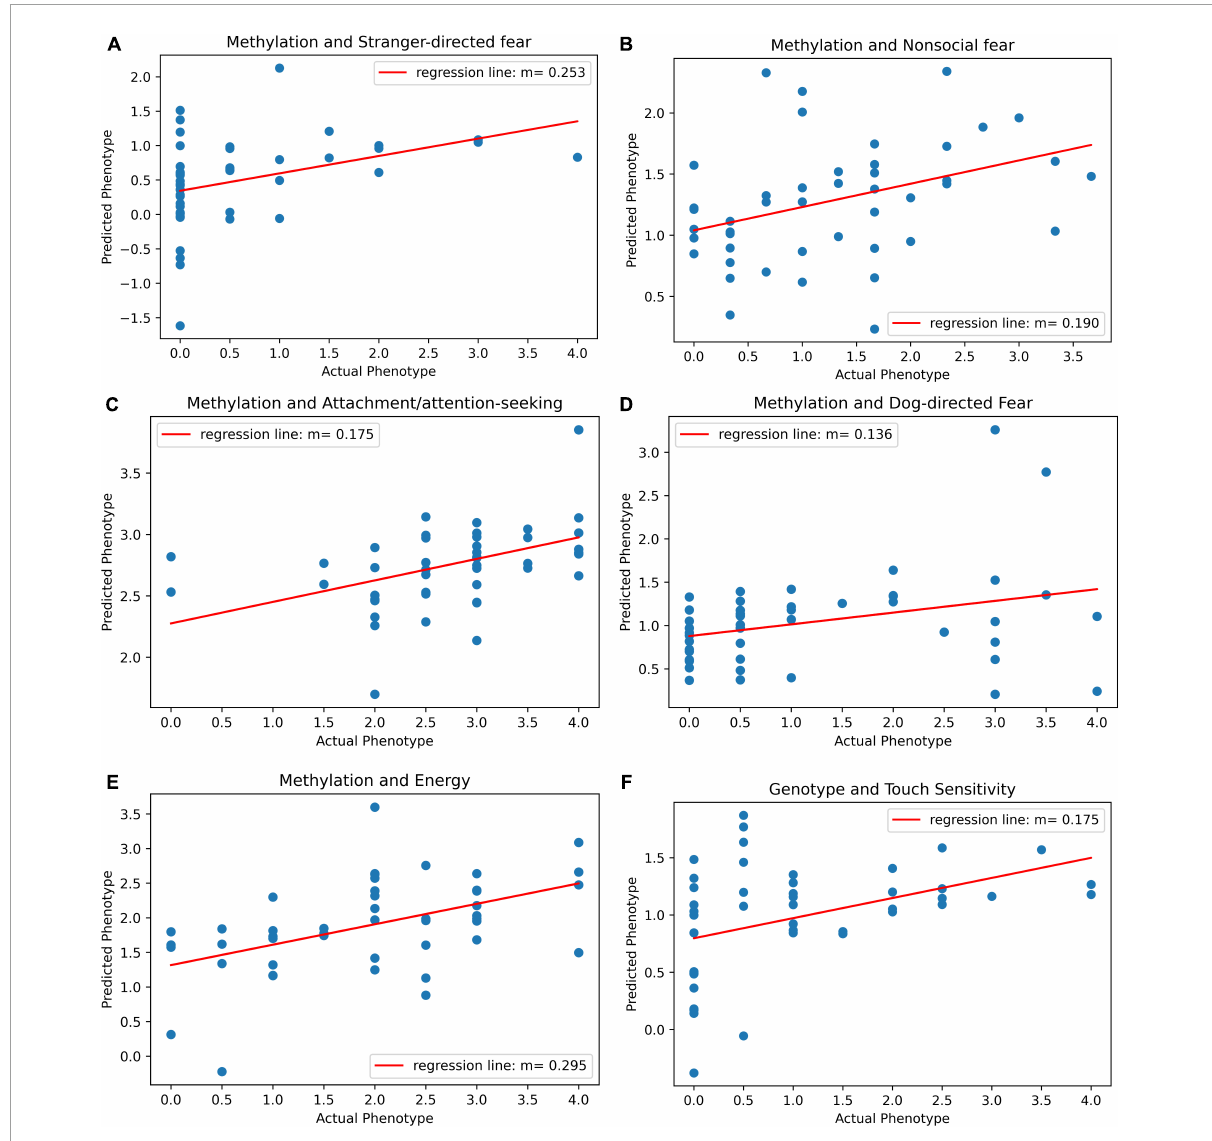
FIGURE3 (A) Scatter plot of predicted vs. actual phenotype for stranger-directed fear. Actual stranger-directed fear values were recorded by the C-BARQ survey. Predicted phenotype scores were generated by PLS regression on methylation values. The plot specifies the slope of the best-fit line through the plotted points. (B) Scatter plot of predicted vs. actual phenotype for non-social fear. Actual non-social fear values were recorded by the C-BARQ survey. Predicted phenotype scores were generated by PLS regression on methylation values. The plot specifies the slope of the best-fit line through the plotted points. (C) Scatter plot of predicted vs. actual phenotype for attachment/attention-seeking. Actual attachment/attention-seeking values were recorded by the C-BARQ survey. Predicted phenotype scores were generated by PLS regression on methylation values. The plot specifies the slope of the best-fit line through the plotted points. (D) Scatter plot of predicted vs. actual phenotype for dog-directed fear. Actual dog-directed fear values were recorded by the C-BARQ survey. Predicted phenotype scores were generated by PLS regression on methylation values. The plot specifies the slope of the best-fit line through the plotted points. (E) Scatter plot of predicted vs. actual phenotype for energy. Actual energy values were recorded by the C-BARQ survey. Predicted phenotype scores were generated by PLS regression on methylation values. The plot specifies the slope of the best-fit line through the plotted points. (F) Scatter plot of predicted vs. actual phenotype for touch sensitivity. Actual touch sensitivity values were recorded by the C-BARQ survey. Predicted phenotype scores were generated by PLS regression on genotype values. The plot specifies the slope of the best-fit line through the plotted points.